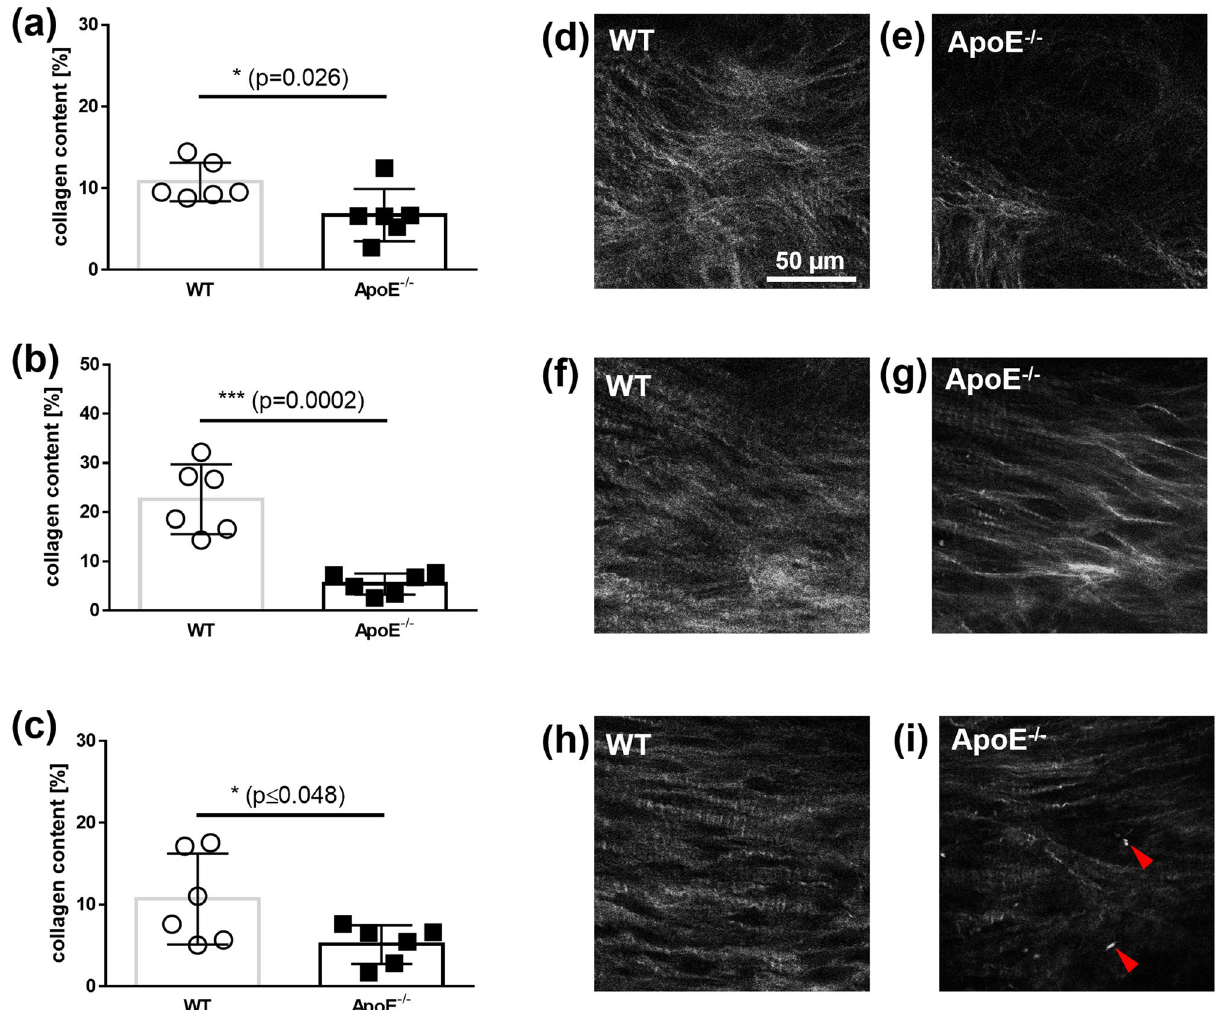
Figure 3. Quantitative analysis of the collagen content in a leaflet using SHG images. The mean collagen content from WT mice and ApoE −/− mice from ( a ) the region 1; from ( b ) region 2; and from ( c ) the region 3. Representative SHG images of the region 1 of the aortic valve leaflets from ( d ) WT mice and ( e ) ApoE −/− mice. Representative SHG images of the region 2 from ( f ) WT mice and ( g ) ApoE −/− mice. Representative SHG images of the region 3 of ( h ) WT mice and ( i ) ApoE −/− mice, acquired in the middle of the thickness. The dimensions of all images are 140 µm × 140